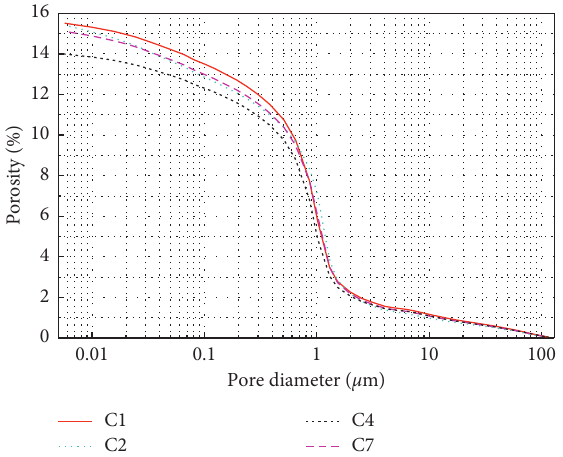
Figure 11: MIP results of hardened MPC-based grouting material after curing for 28